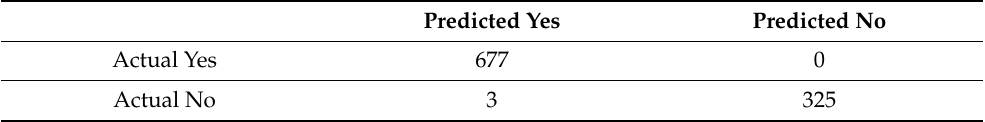
Table 8. Random forest confusion matrix.